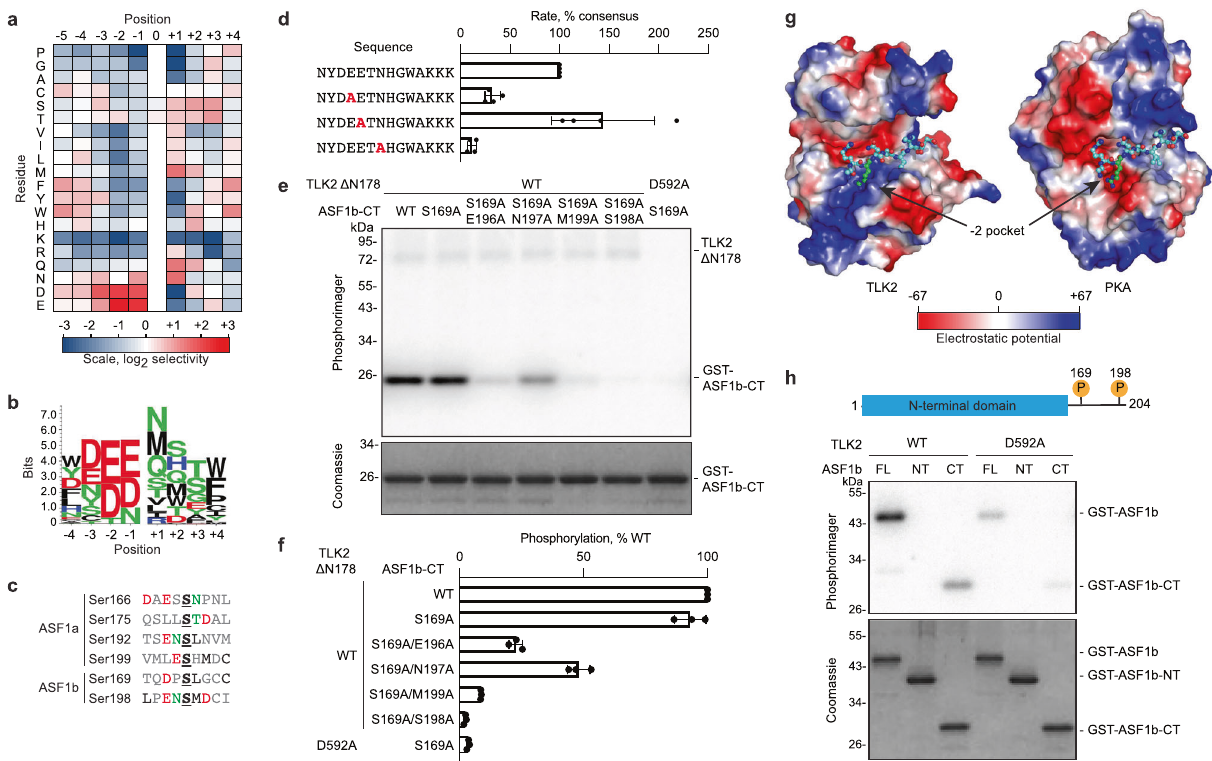
Fig. 1 Optimal TLK2 phosphorylation of the C-terminal tails of ASF1 proteins is driven by both phosphorylation site speci fi city and the NT domain of ASF1. a Heat map depicting amino acid selectivity at positions surrounding a Ser/Thr phosphorylation site determined from arrayed PSPL analysis of TLK2 Δ N178. The heat map shows normalized, log2 transformed PSPL spot intensities averaged across two separate experiments. Numerical values are provided in Supplementary Table 1. b Sequence logos showing positively selected residues were generated from the data shown in a using Seq2Logo 91 . c Sequences of previously reported phosphorylation sites on human ASF1a and ASF1b. d Relative rates of TLK2 Δ N178 phosphorylation of a synthetic consensus peptide substrate (top) and Ala substitution variants (bars show mean ± SD, n = 4 independent experiments). e Representative assay showing TLK2 Δ N178 phosphorylation of puri fi ed GST-tagged ASF1b-CT (residues 155-202) and ASF1b-CT mutants was assessed in kinase assays in vitro. A kinase inactive TLK2-D592A mutant was included as a control. f Quanti fi ed results from three independent replicates of the experiment shown in panel e (mean ± SD) (right). g Electrostatic surface potential of the TLK2 and PKA catalytic domains (PDB 5O0Y 51 and 1ATP 52 ) with overlayed peptide fragment from the PKA- PKI complex (PDB 1ATP) generated using Pymol. h Phosphorylation of puri fi ed GST-tagged FL ASF1b (FL), the N-terminal domain (NT, residues 1 – 155) or the C-terminal tail (CT, residues 155 – 202) by puri fi ed FL TLK2 (WT or kinase inactive D592A mutant) was assessed using in vitro kinase assays. Results from one representative experiment of two are depicted, along with a cartoon depicting ASF1b domain organization and major sites of phosphorylation. Source data are provided as a Source Data fi